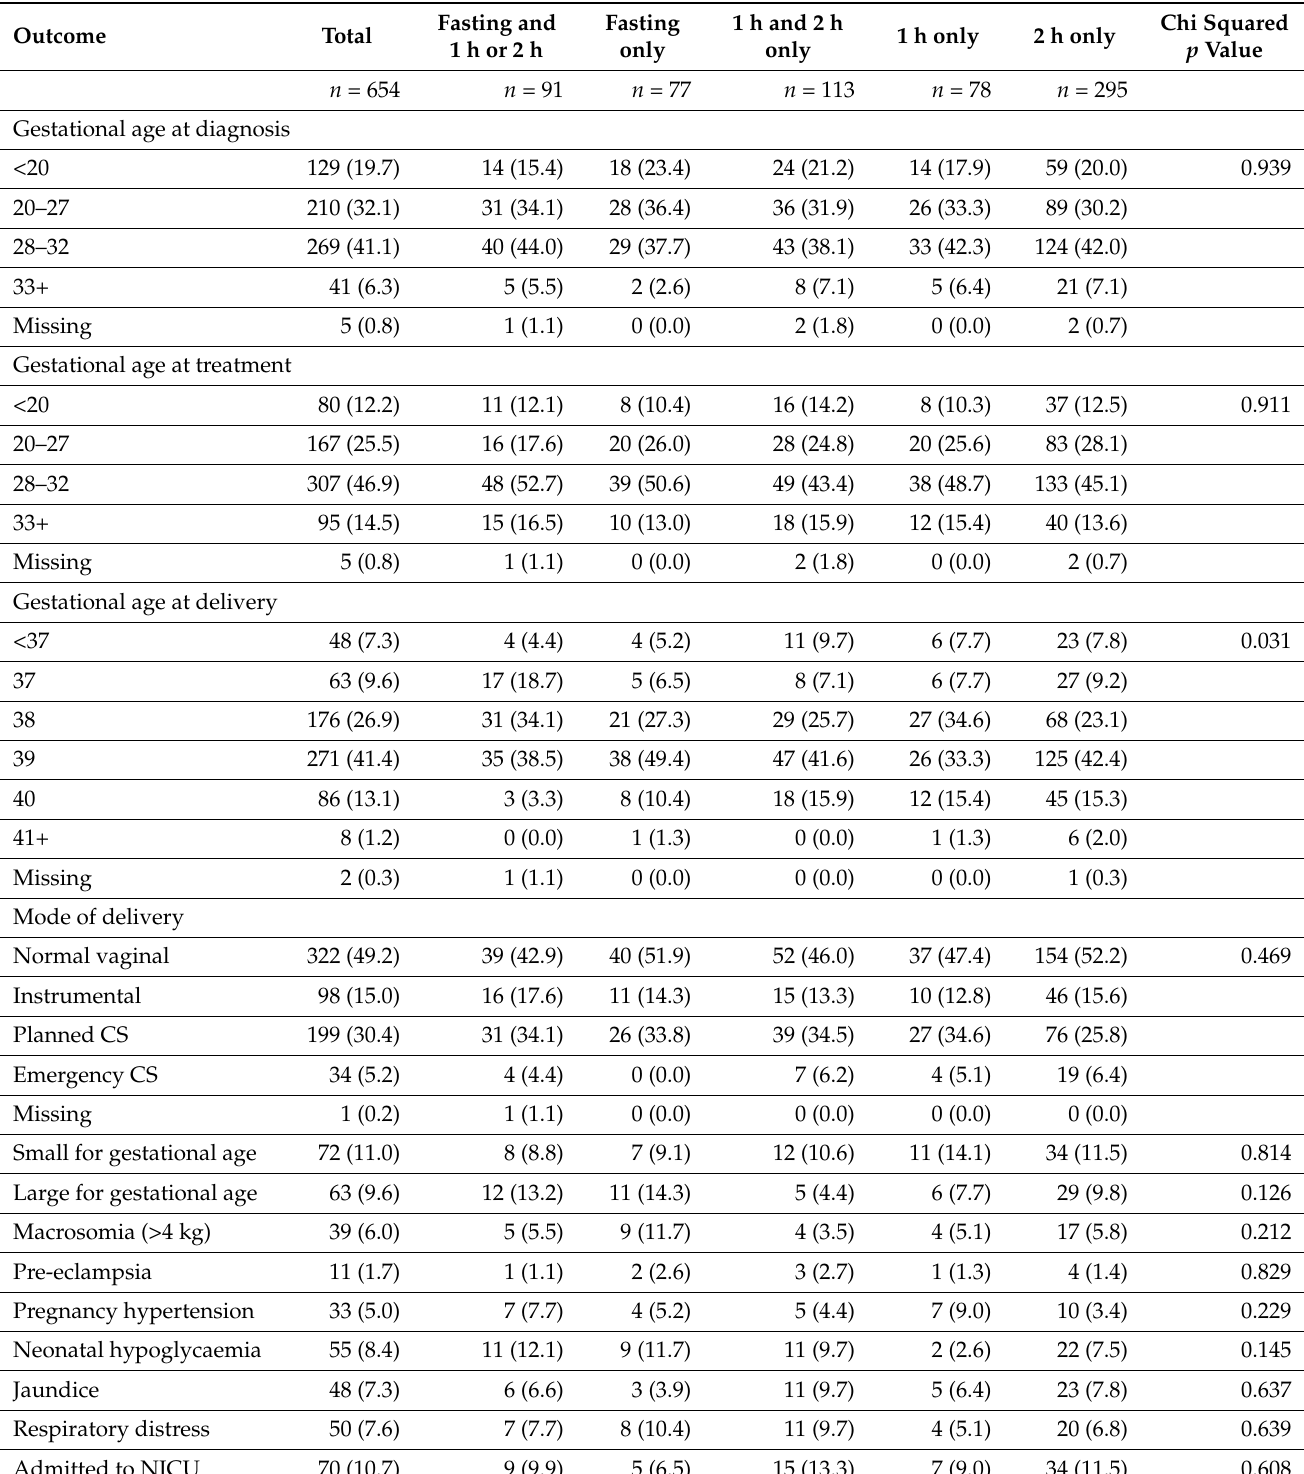
Table 4. GDM diagnostic group and perinatal